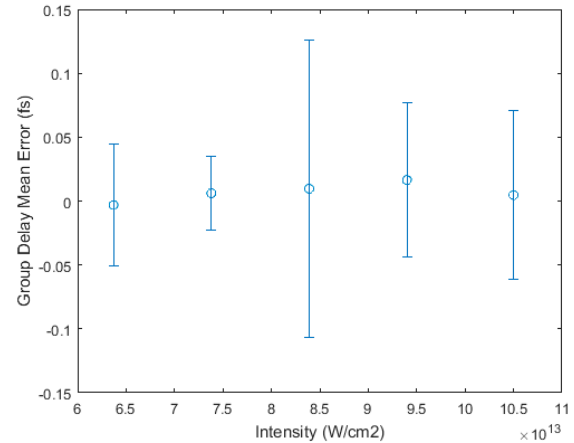
Figure A1. Mean error from the SFA fit in xenon. By applying the SFA fit to the lowest-intensity RABBITT data, and by scaling further calculations relative to the known input power, we found that the SFA calculations in xenon were, within error bars, of zero deviation from the experimental results.